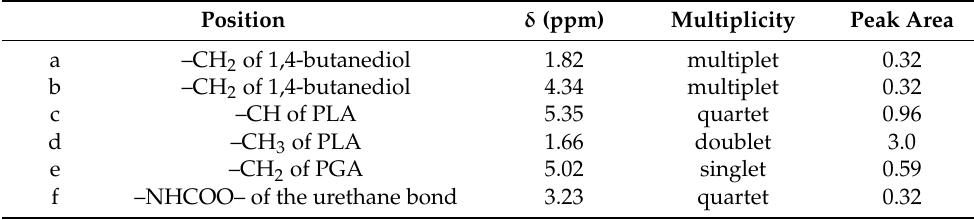
Table 2. 1 H NMR data of PGA–b-PLA multiblock